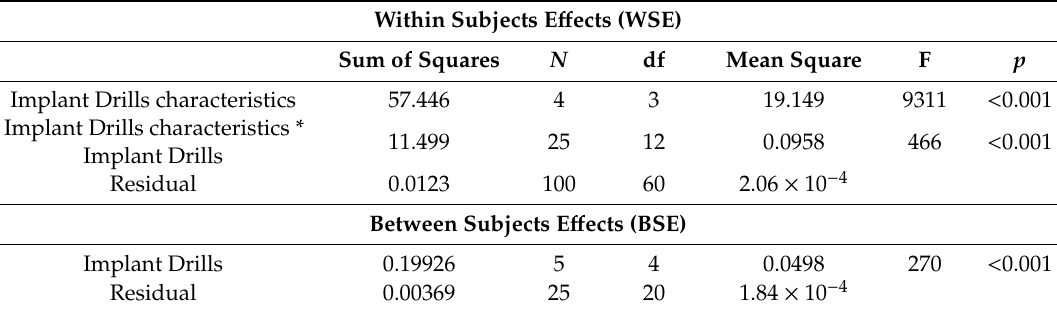
Table 4. Repeated measures ANOVA (RMA) within / between subjects e ff